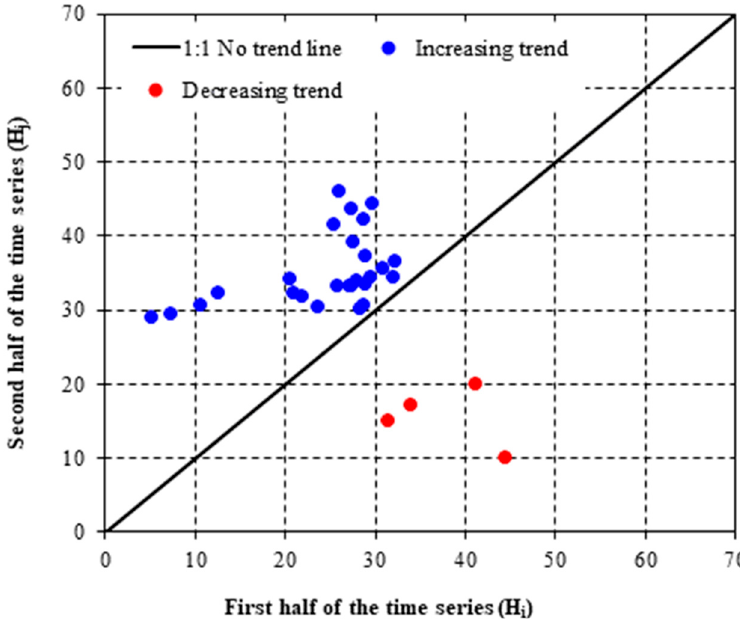
Figure 2. The illustration of the ITA method shows increasing and decreasing trend. The straight-line trend slope ( s ) plotted by the ITA can be calculated according to the following expression [58].